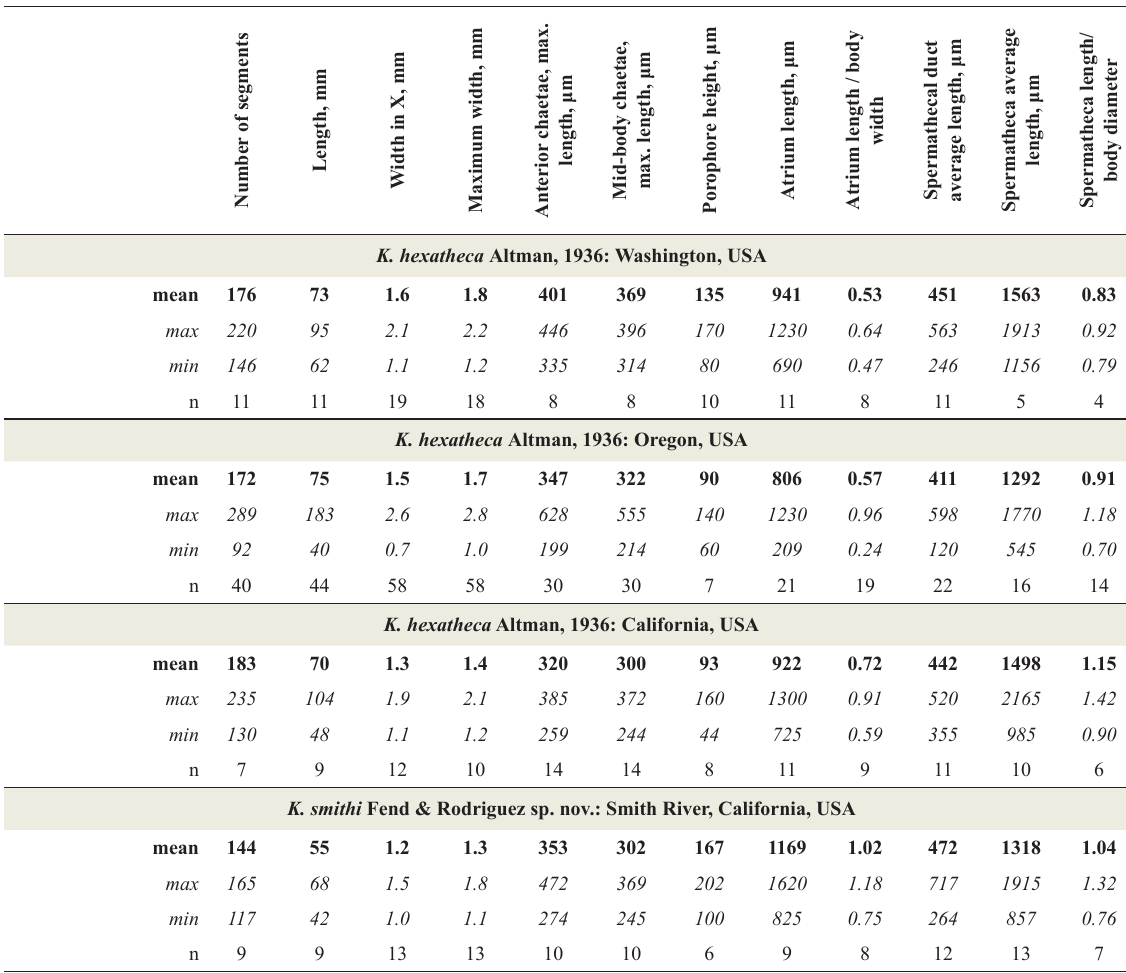
Table 2. Descriptive measurements (mean, range, and n) for Kincaidiana hexatheca Altman, 1936 from different regions (from north to south: Washington, Oregon and California), and K. smithi Fend & Rodriguez sp.